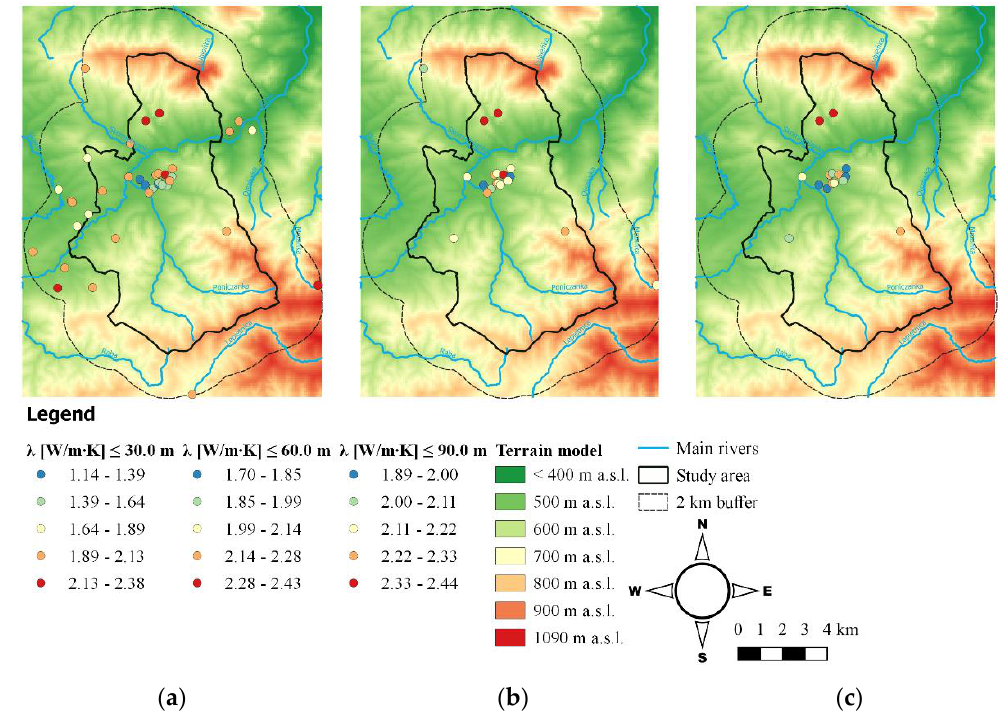
Figure 7. Estimated value of the thermal conductivity of the rock mass to a depth of: ( a ) 30 m; ( b ) 60 m; ( c ) 90 m.